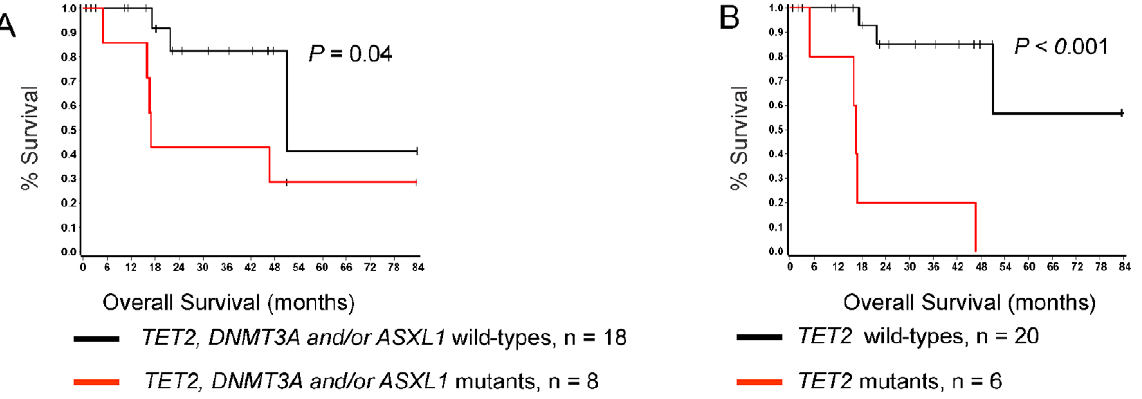
Figure 3. Kaplan-Meier survival curves estimated according to presence of specific mutations or accumulation of several mutations in patients with systemic mastocytosis. Differences in OS for SM patients are shown (A-B). For each group number of analyzed cases and P value are presented, respectively.